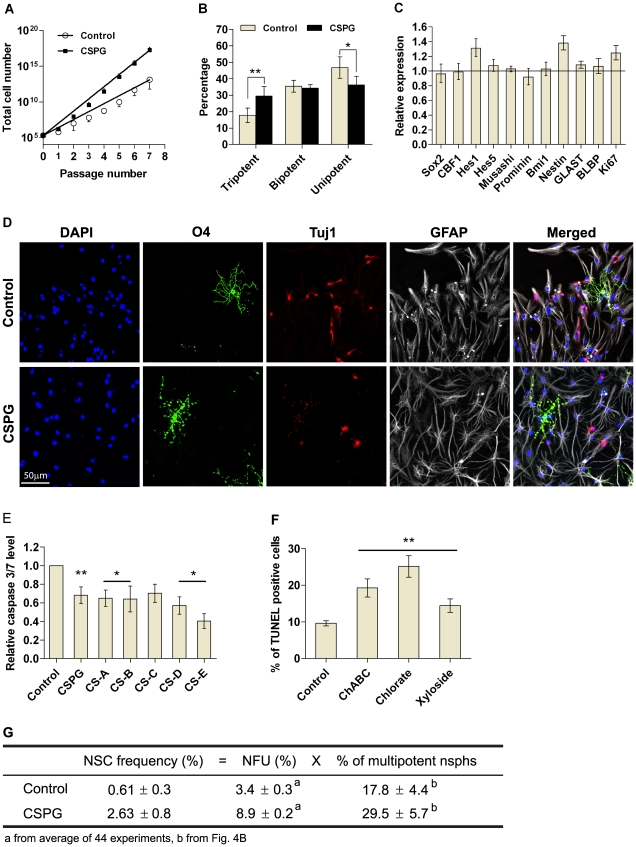
CSPG stimulates NSC survival.(A) Cells were plated at 2×103 cells/ml with CSPG (50 µg/ml) or without (control). Nsphs were passaged every seven days with cells replated at the same density and treatment conditions. Cell numbers were counted at each passage and plotted against passage number. (B) Statistical analysis of the multipotency of individual nsphs. Individual clonal nsphs grown with or without CSPG (50 µg/ml) were differentiated (see Materials and Methods) and scored as follows; tripotent (neurons, astrocytes and oligodendrocytes), bipotent (neurons/astrocytes or oligodendrocytes/astrocytes), unipotent (astrocytes). Data are presented as mean ± SEM with n≥347 (from 6 experiments); * P≤0.05, ** P≤0.01. (C) Gene expression of individual clonal nsphs grown with or without CSPG (50 µg/ml) was measured by quantitative RT-PCR as described in the supplementary Materials and Methods S1. The bar chart show changes in gene expression induced by CSPG with a value of 1 indicating no change. Data are presented as mean ±95% confidence interval with n≥70 (from 3–10 experiments). (D) Representative images of differentiated nsphs stained for the lineage markers O4 (oligodendrocyte; green), Tuj1 (neuron, red) and GFAP (astrocyte, gray). Nuclei were counterstained with DAPI (blue). The merged image shows co-localization of all three cell types. Scale bar  = 50 µm at 20X objective. (E) Dissociated cells were plated at bulk density in GM with or without CSPG or CS-A to –E (all at 50 µg/ml) for 24 hours. Bar chart shows active caspase 3/7 level as determined by the Caspase-Glo 3/7 kit. (F) Dissociated cells were plated onto PLL coated coverslips at 5×105 cells/13 mm coverslip in GM containing chABC (20 mU/ml), chlorate (50 mM) or xyloside (150 µM) for 24 hours. Cells were fixed and stained with DeadEnd Fluorometric TUNEL kit. Bar chart shows percentage of TUNEL positive cells with each treatment. Data are presented as means ± SEM with n≥9 (from 4–5 experiments); * P≤0.05, ** P≤0.01 compared to control, bar represent same significance level compared to control. (G) NSC frequency was calculated by multiplying NFUs with the percentage of multipotent nsphs.